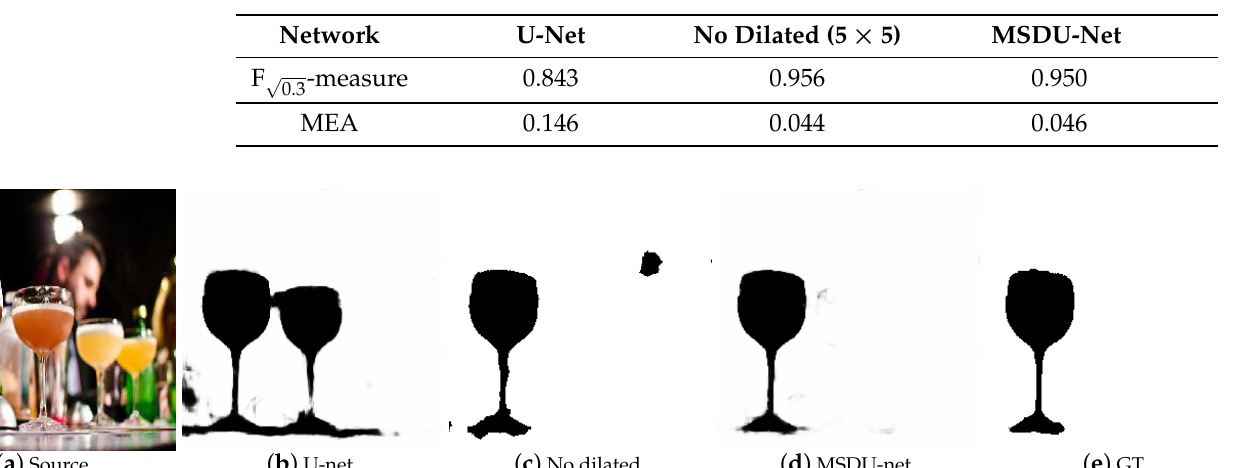
-measure and MEA scores among no dilatited (using 5 × 5 0.3